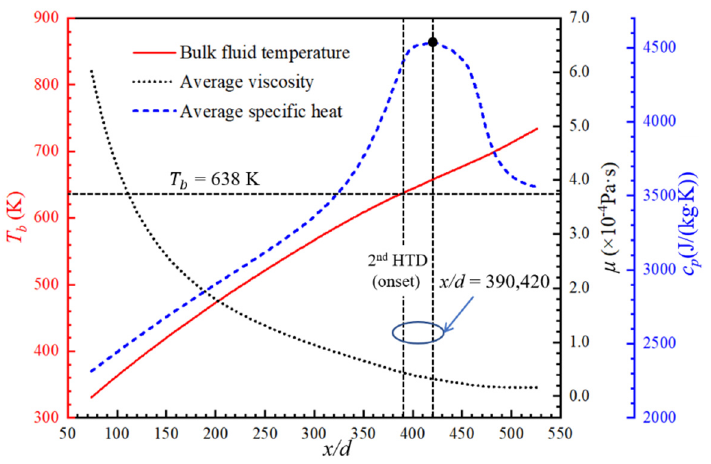
Figure 10. Bulk flow parameters along the flow direction.